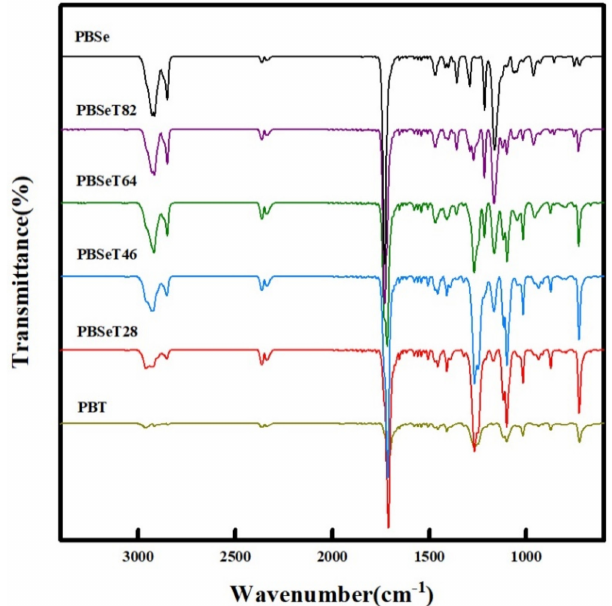
Figure 4. Fourier-transform infrared spectra (FT-IR) of the six di ff erent copolyester